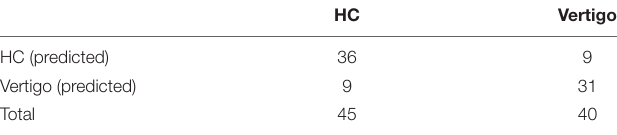
TABLE 3 | Confusion matrix of support vector machine classification.